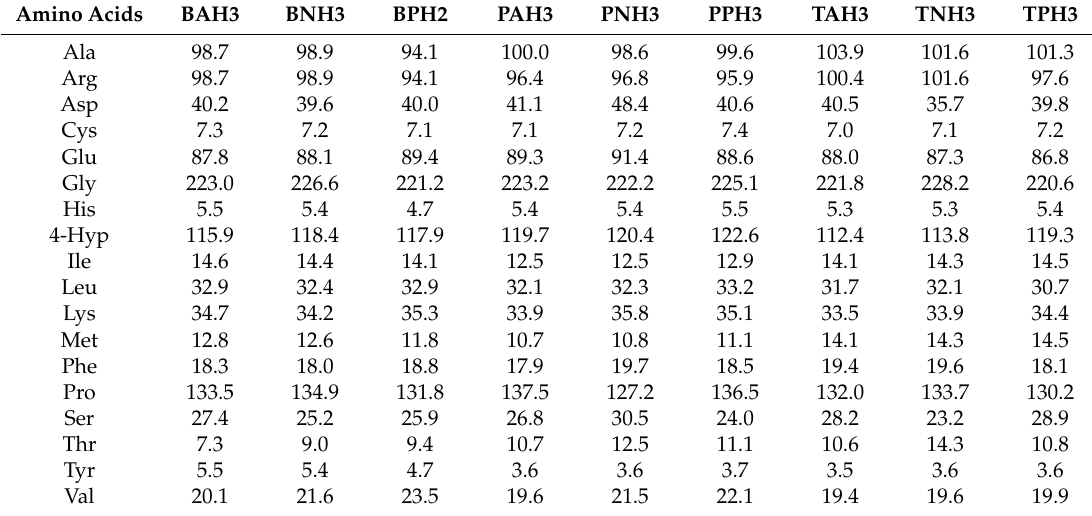
Table 3. Amino acid compositions (g/kg of protein) of the assessed hydrolysates.